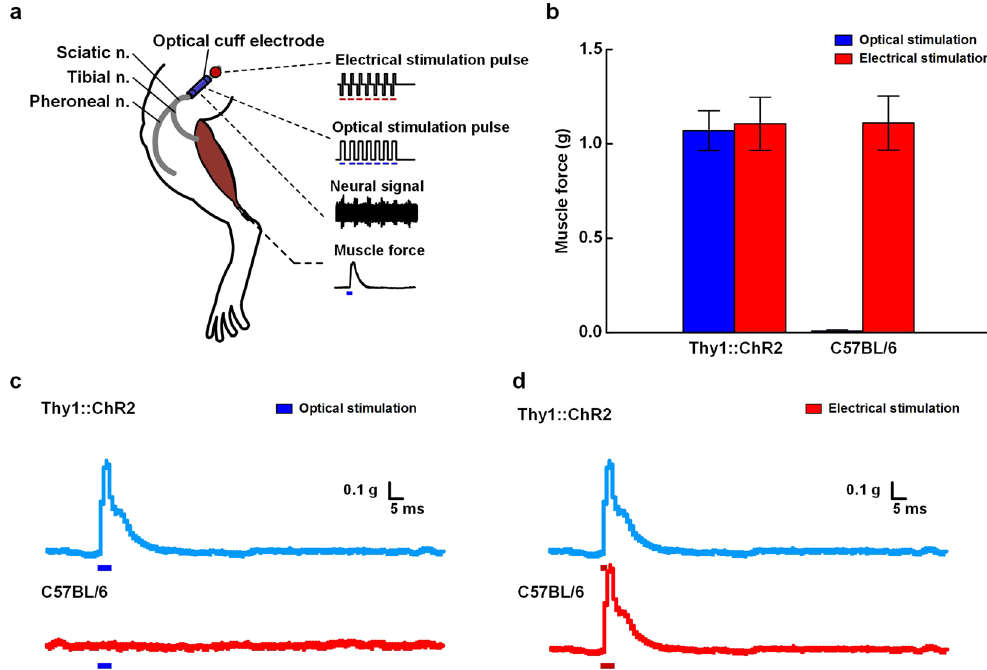
Figure 3. Effects of neural activity monitoring and muscle force measurements during optical and electrical stimulations. ( a ) Experimental setup for the simultaneous recording of neural activity during the optical and electrical stimulations. ( b ) Change in the muscle force during the optical and electrical stimulations in Thy1::ChR2 and C57BL/6 mice. Electrical stimulation pulse (biphasic pulses; pulse duration: 100 μ s; current amplitude: 150 μ A; and repeated frequency: 20 Hz) and optical stimulation pulse (pulse duration: 5 ms; illumination intensity: 10 mW/mm 2 ; and repeated frequency: 20 Hz). ( c , d ) Typical force traces in Thy1::ChR2 and C57BL/6 mice during the optical and electrical stimulations. A single pulse stimulation is induced by either electrical (pulse duration: 100 μ s; current amplitude: 150 μ A) or optical (pulse duration: 5 ms; illumination intensity: 10 mW/mm 2 )